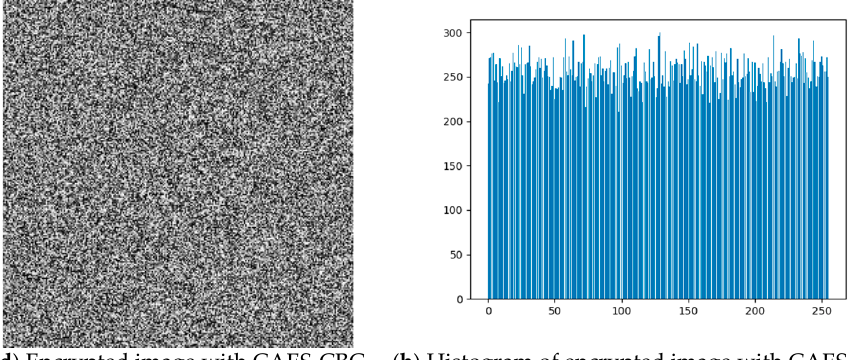
Figure 11. The visual effect and histograms of the plain and cipher images